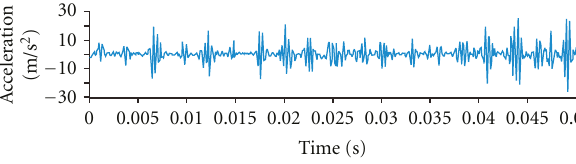
Figure 10: De-noised signal of vibrations of a gear with a pinion with a crack with Hybrid threshold.